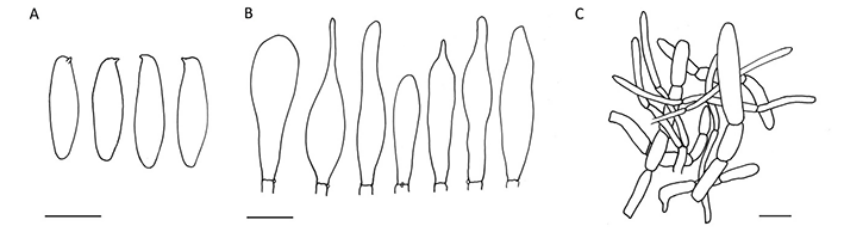
Figure 8 Microcharacters of Leccinum brunneogriseolum Lannoy & Estadès: ( A ) spores; ( B ) cheilocystidia; ( C ) pileipellis. Scale bars: 10 µ